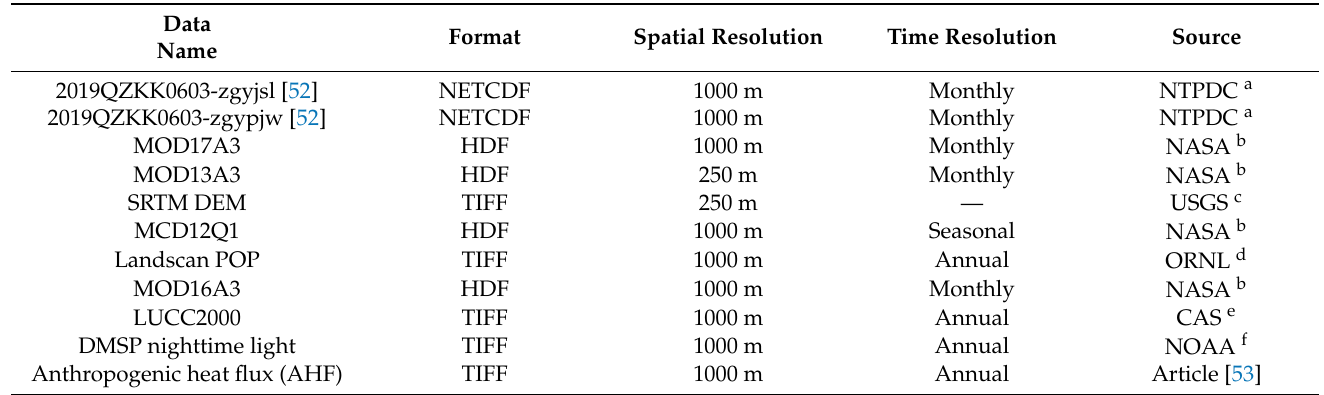
Table 1. Detailed description of the